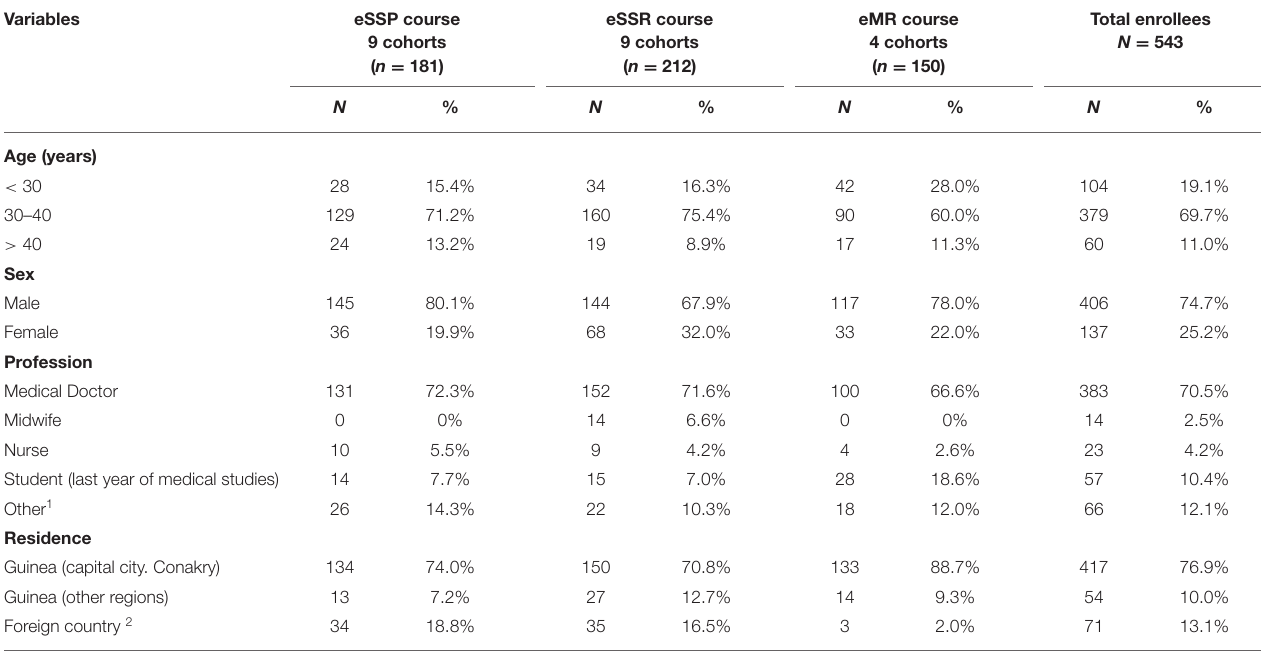
TABLE 2 | Sociodemographic characteristics of participants to three blended courses in Primary Health Care (eSSP), Management of Sexual and Reproductive Health Services (eSSR) and Research methods (eMR), Guinea, 2018–21.